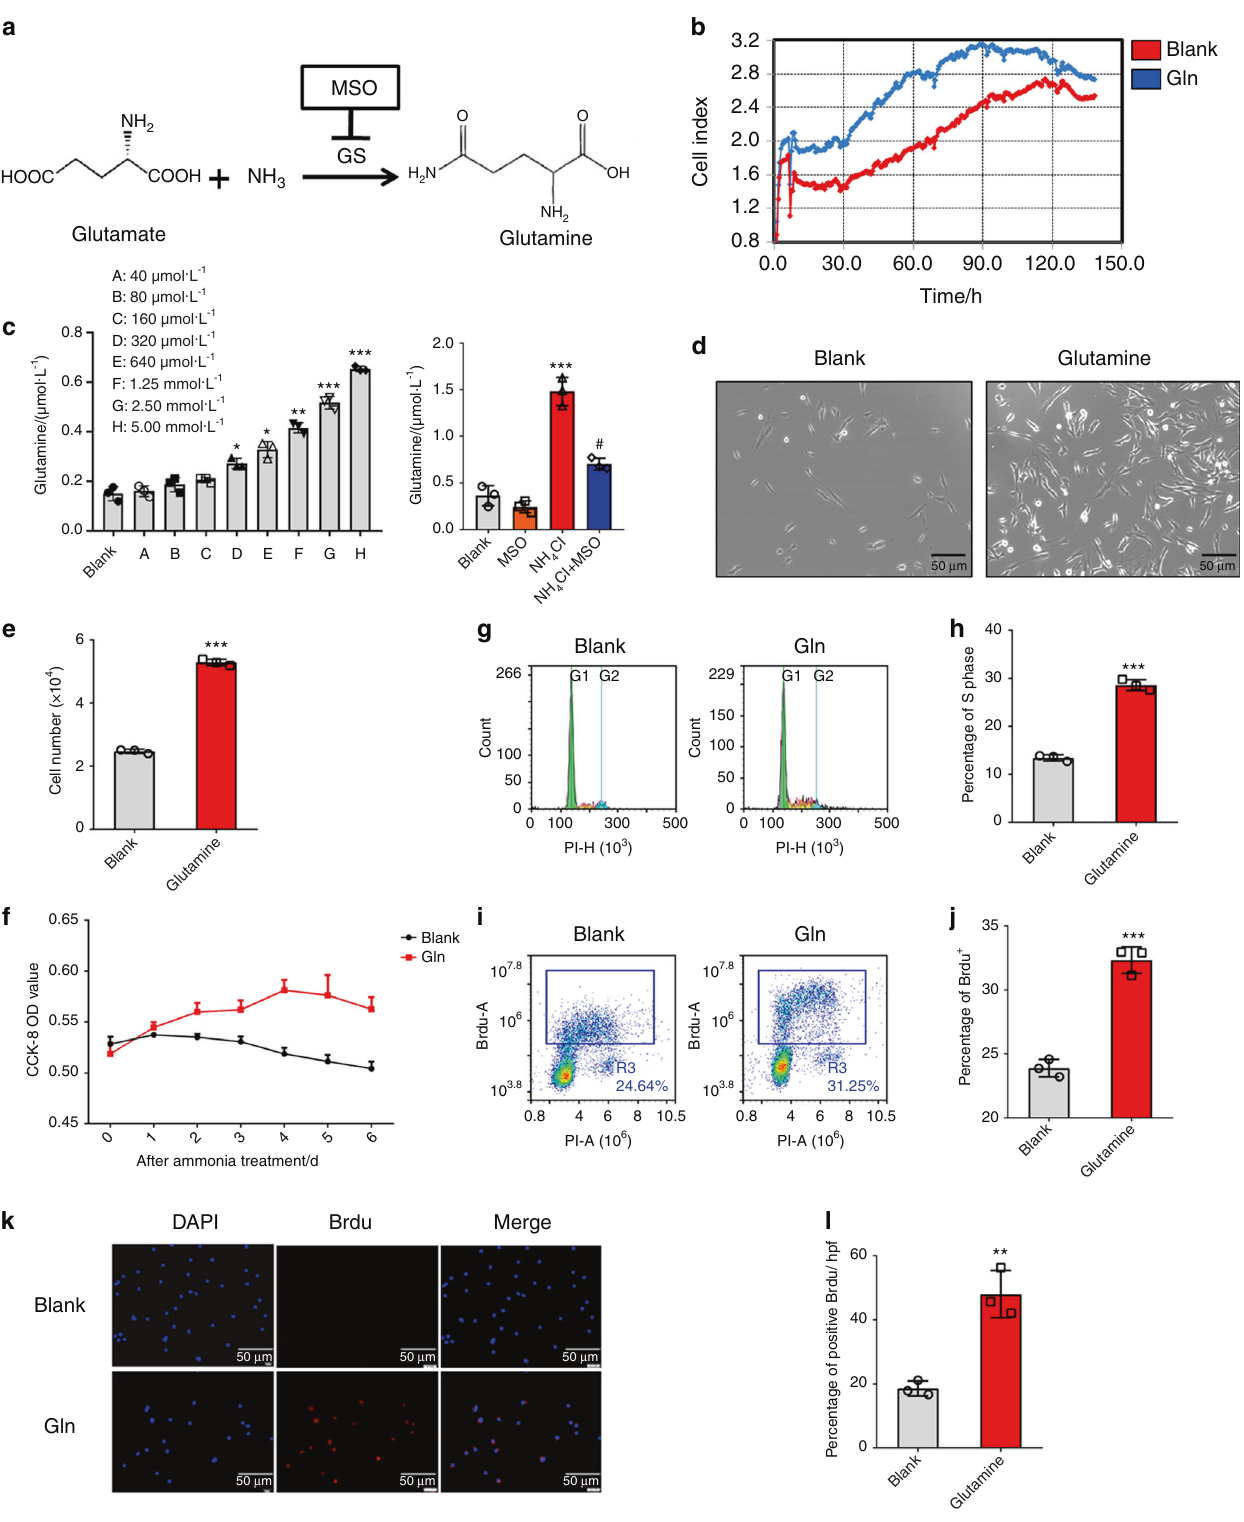
Fig. 3 Glutamine promotes mesenchymal stem cell proliferation. a Metabolic pathway of ammonia in GS-expressing MSCs. b RTCA (real-time cellular analysis) with or without glutamine treatment. c Determination of glutamine after NH 4 Cl treatment (left) and with or without both NH 4 Cl treatment and MSO treatment (right). d The growth of MSCs with or without glutamine treatment under a microscope. e The results of cell count analysis with or without glutamine treatment. f CCK-8 analysis with or without glutamine treatment lasting 1 week. g PI fl ow analysis. h The statistical results of the percentage of S phase cells. i BrdU fl ow analysis. j The statistical results of the percentage of BrdU + cells. k Immuno fl uorescence analysis of BrdU. l The statistical results of BrdU + cells/HPF. Values are the mean ± SEM of an experiment performed in triplicate (one-way analysis of variance). * P < 0.05 versus the controls. # P < 0.05 versus the 5 mmol·L − 1 NH 4 Cl treatment